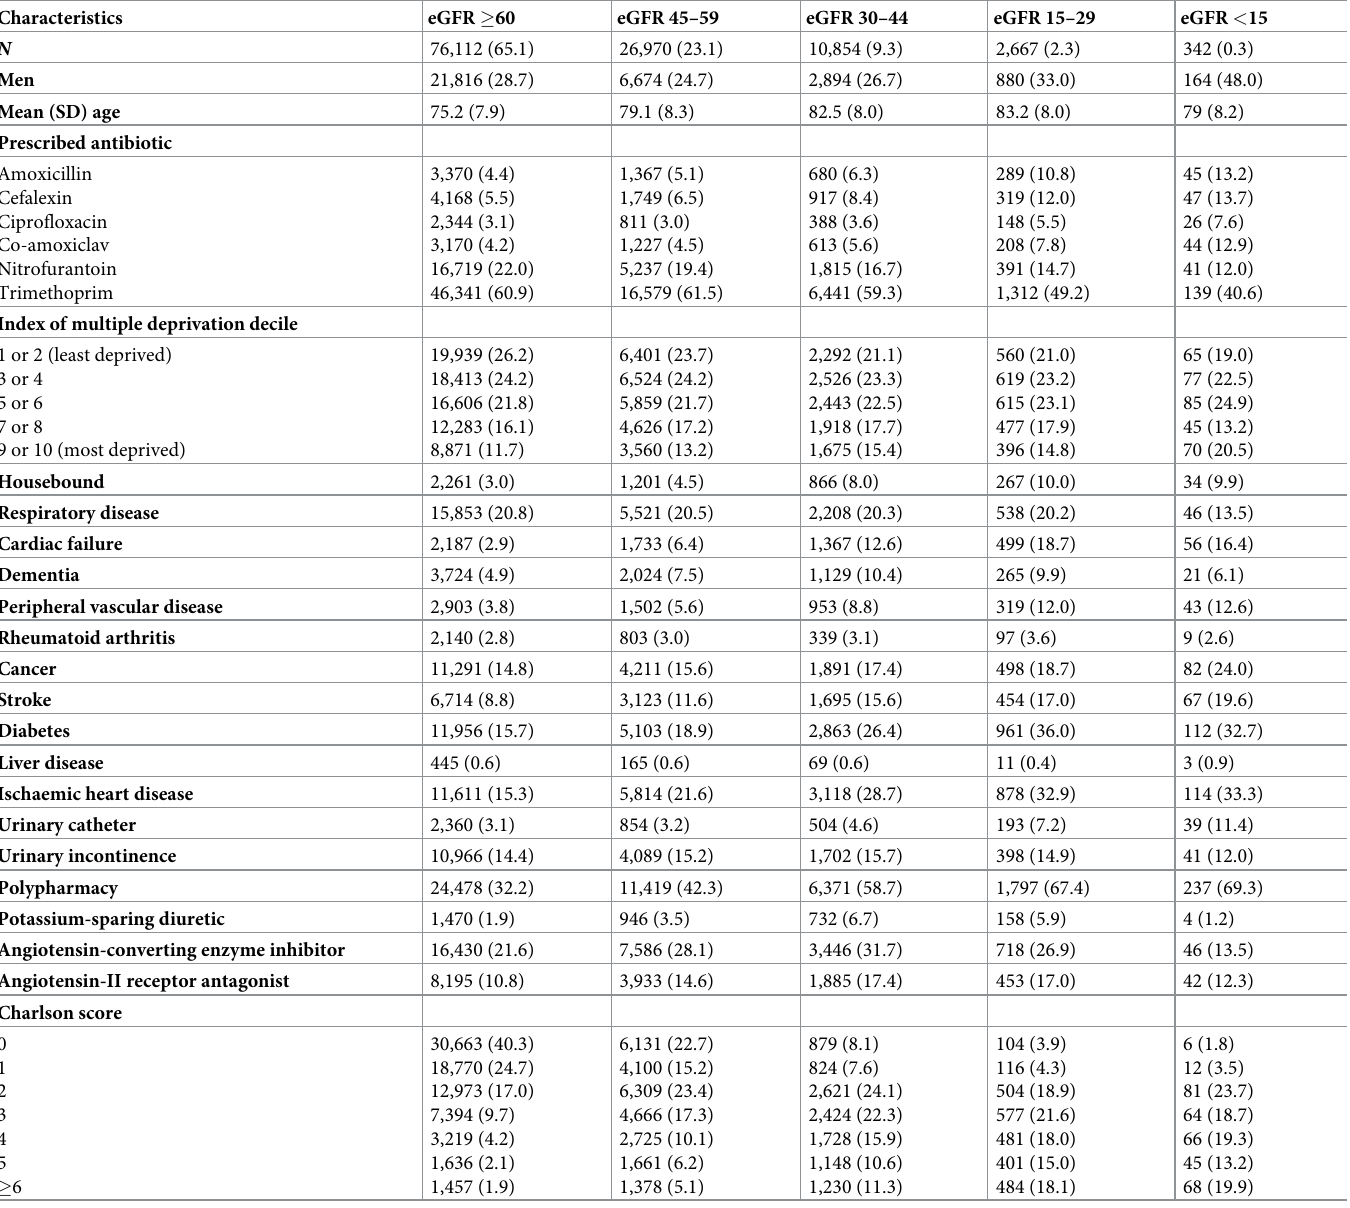
Table 1. Baseline characteristics of included patients according to eGFR